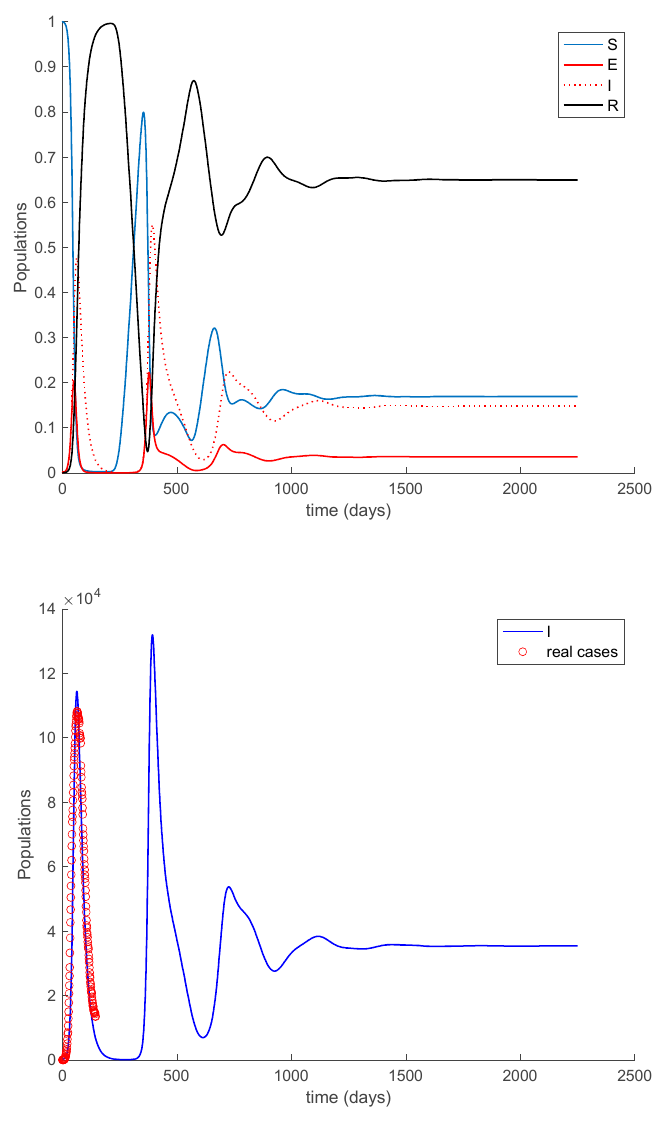
Figure 16. Dynamics of the model for the COVID-19 pandemic in Italy for Case 2.2. There is no vaccination, and there is an exponentially fast loss of immunity with delay.